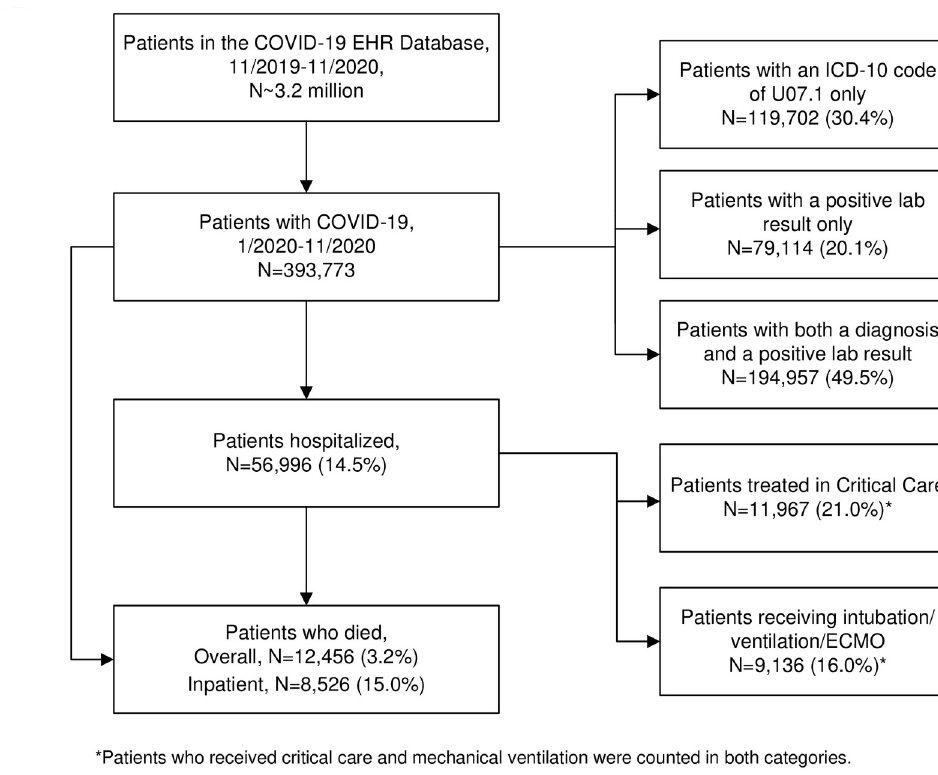
Fig 1. Flowchart of diagnosed COVID-19 cases: The Optum EHR COVID-19 database January-November 2020. � Patients who received critical care mechanical ventilation were counted in both categories.